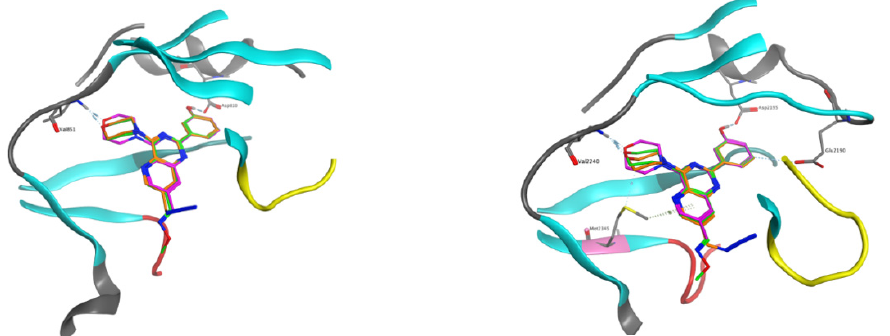
Figure 5. Binding modes from docking for compounds 6 (pink), 19 (orange) and 32 (green) in PI3K α ( left ) and mTOR ( right ).